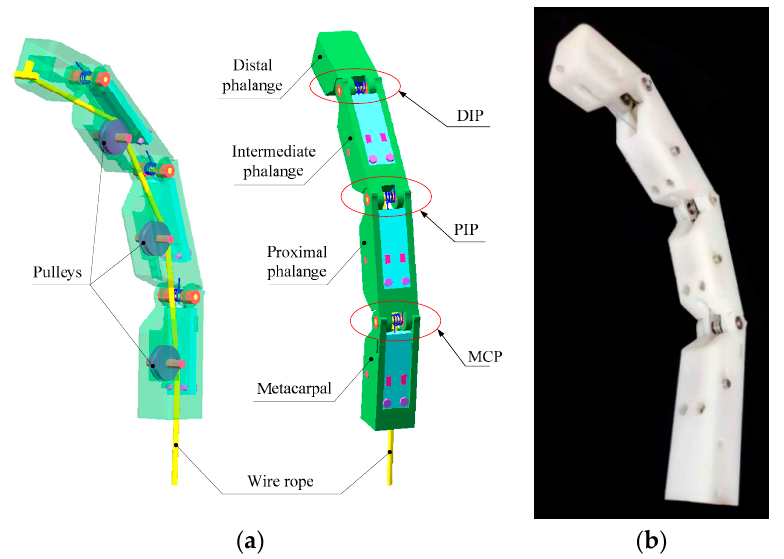
Figure 1. The 3-D model and prototype of the designed finger. ( a ) 3-D model of the designed fin- ger; ( b ) Prototype of the designed finger. ( b ) Prototype of the designed